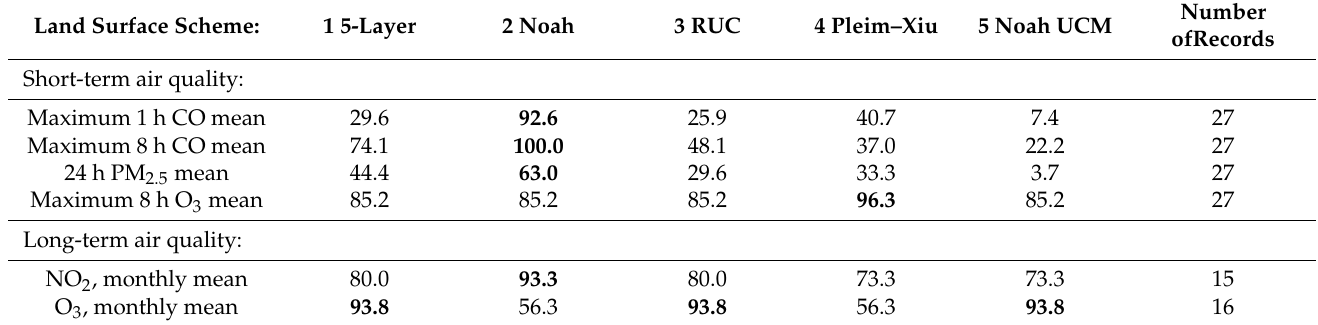
Table 8. Percentages of the records that were captured by modeling. Air quality variables. Bold numbers highlight the schemes with the best